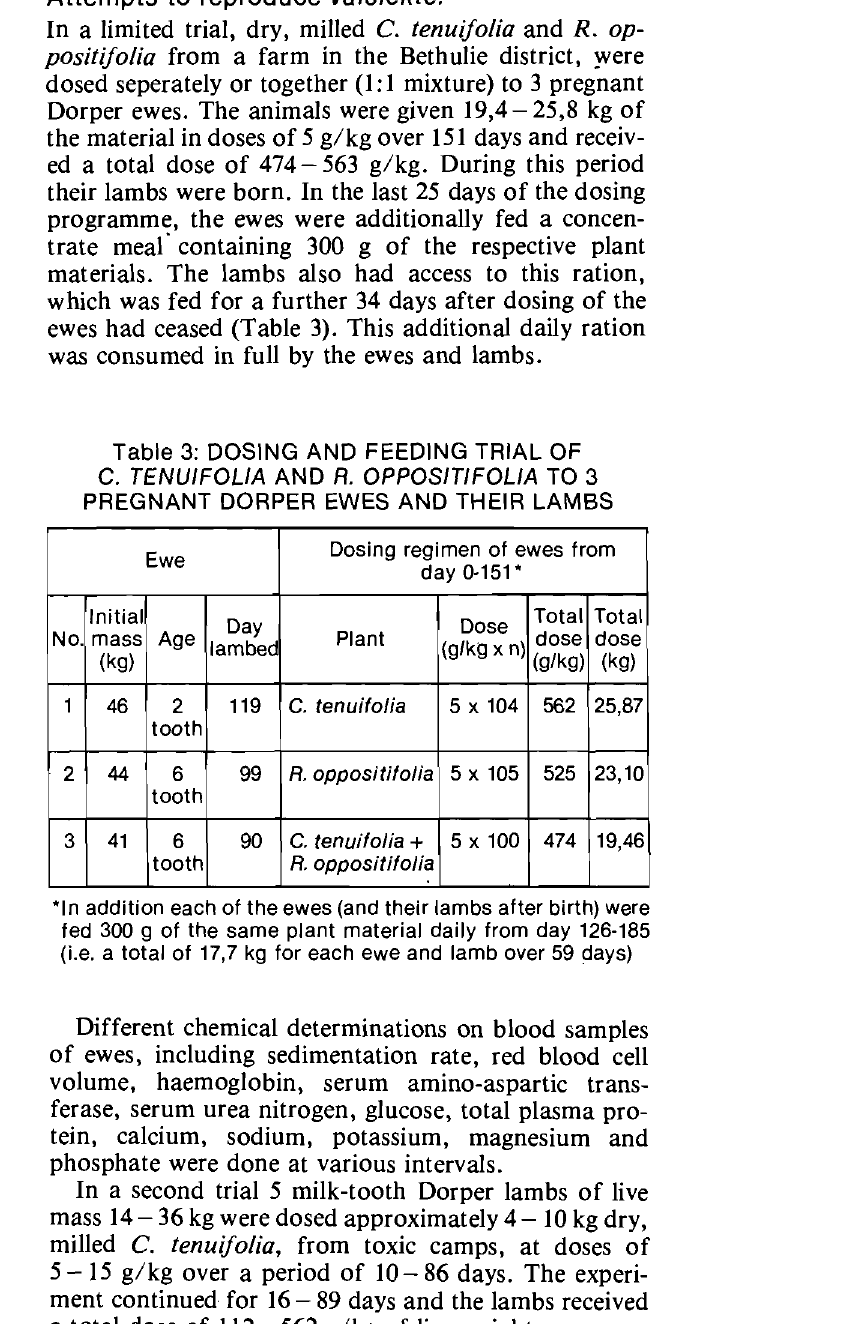
Table 2: THE LIVER TRACE ELEMENT LEVELS (p.p.m.) ON A WET BASIS, OF AFFECTED FIELD CASE LAMBS Sheep